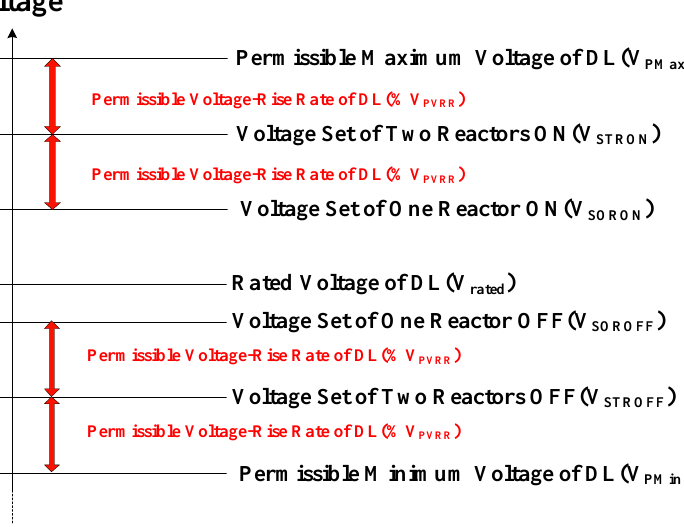
Figure 6. Voltage set of DL for ON and OFF of reactors.